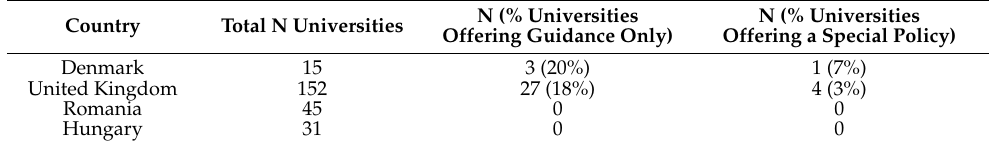
Table 3. Distribution of the number and percentage of universities which offered guidance or a special policy for managing work from home for employees with additional care responsibilities. Country